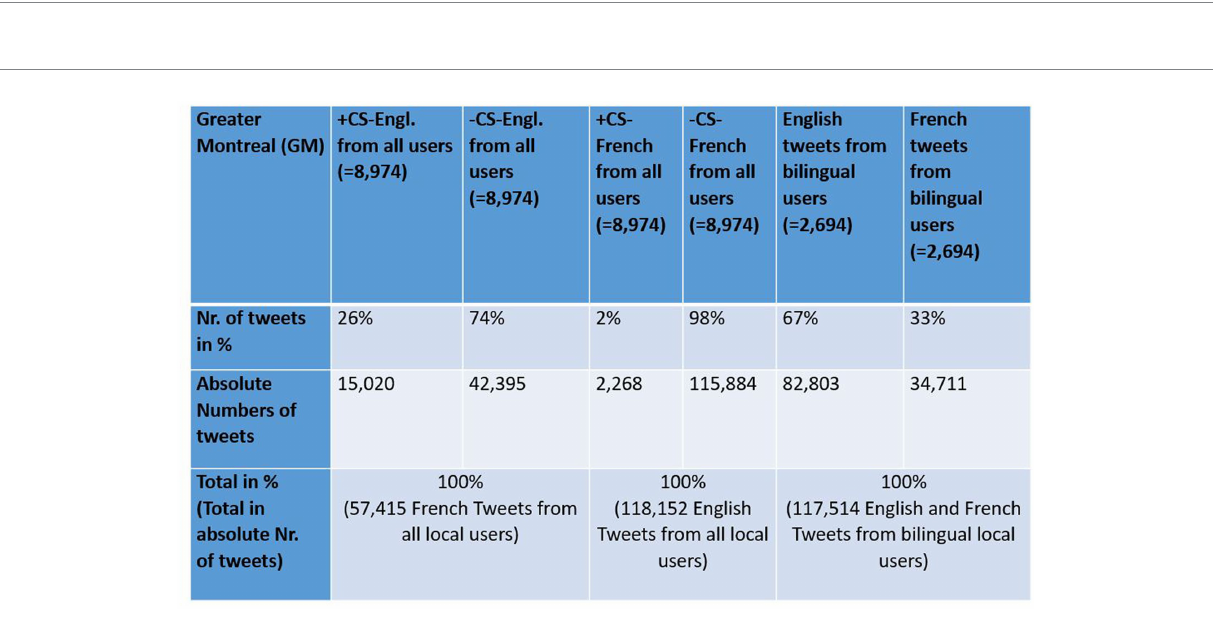
FIGURE 3 Distribution of Language use [+/ − CS-Engl., +/ − CS-French, LCB (English), and LCB (French)] in